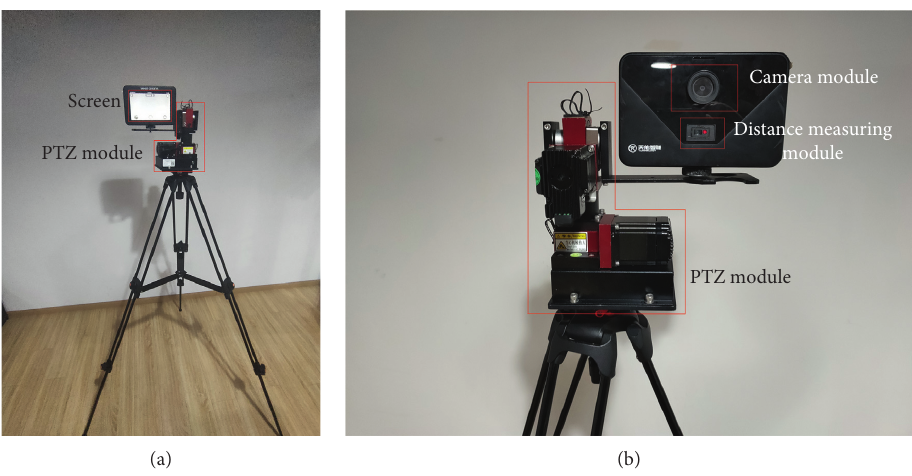
Figure 1: Module composition and usage scenarios of CameraPad.